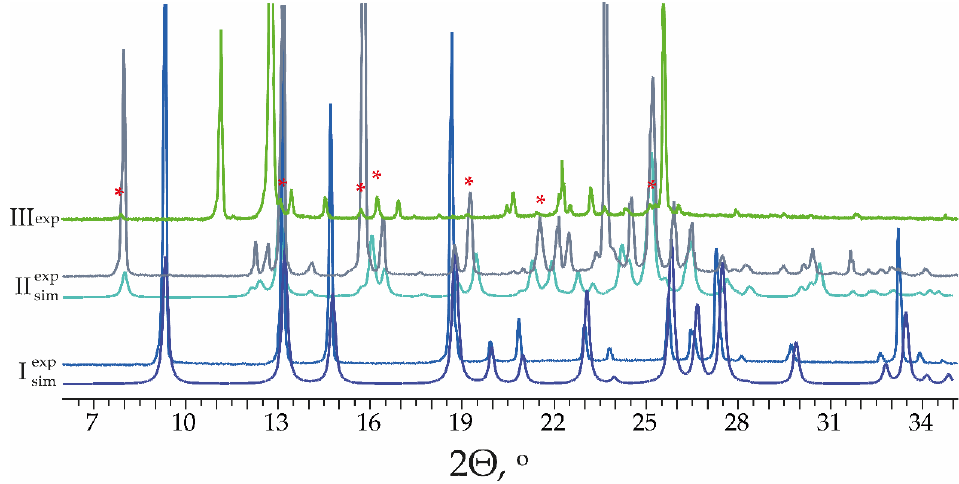
Figure 2. Simulated and experimental PXRD patterns of MPBA polymorphs. The possible Form II impurity in the Form III sample is marked with red asterisks. Table 1. Polymorphic outcome of crystallization from pure solvents.